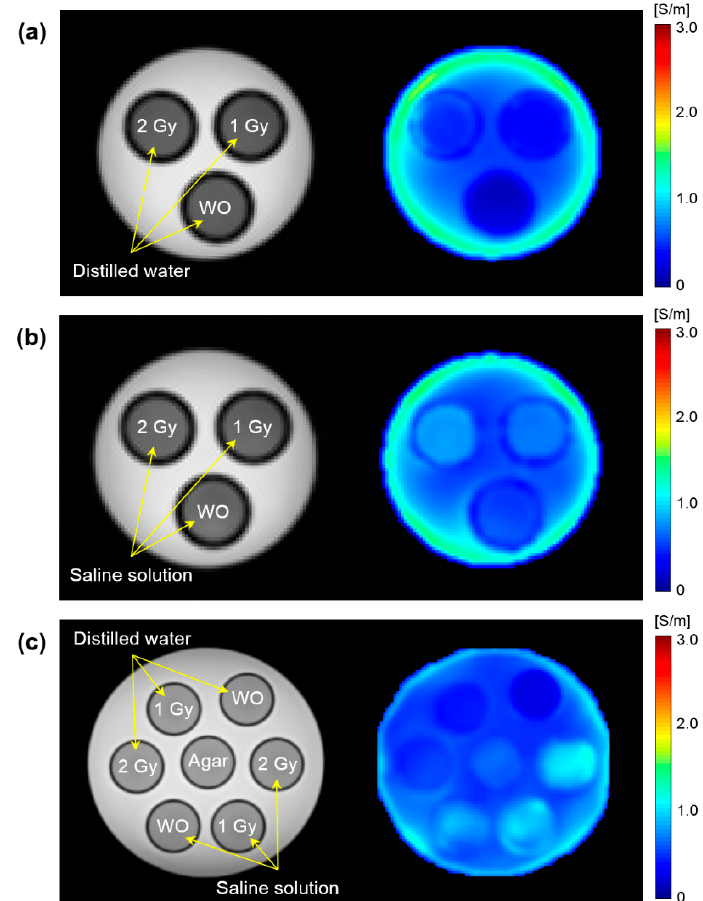
Figure 2. T2-weighted and electrical conductivity images of phantom with distilled water ( a ) and saline solution ( b ). The cylindrical tank was exposed to irradiation without and with 1 and 2 Gy doses and an imaging experiment was performed at 9.4T MRI. Phantom imaging with a combination of two solutions ( c ) was also performed on clinical 3T MRI. WO stands for without irradiation. Table 1. Summary of electrical conductivity and relative conductivity change in phantom imaging. The measured conductivity indicates absolute values by irradiation dose. The relative conductivity change indicates the extent of irradiation effects based on the values without